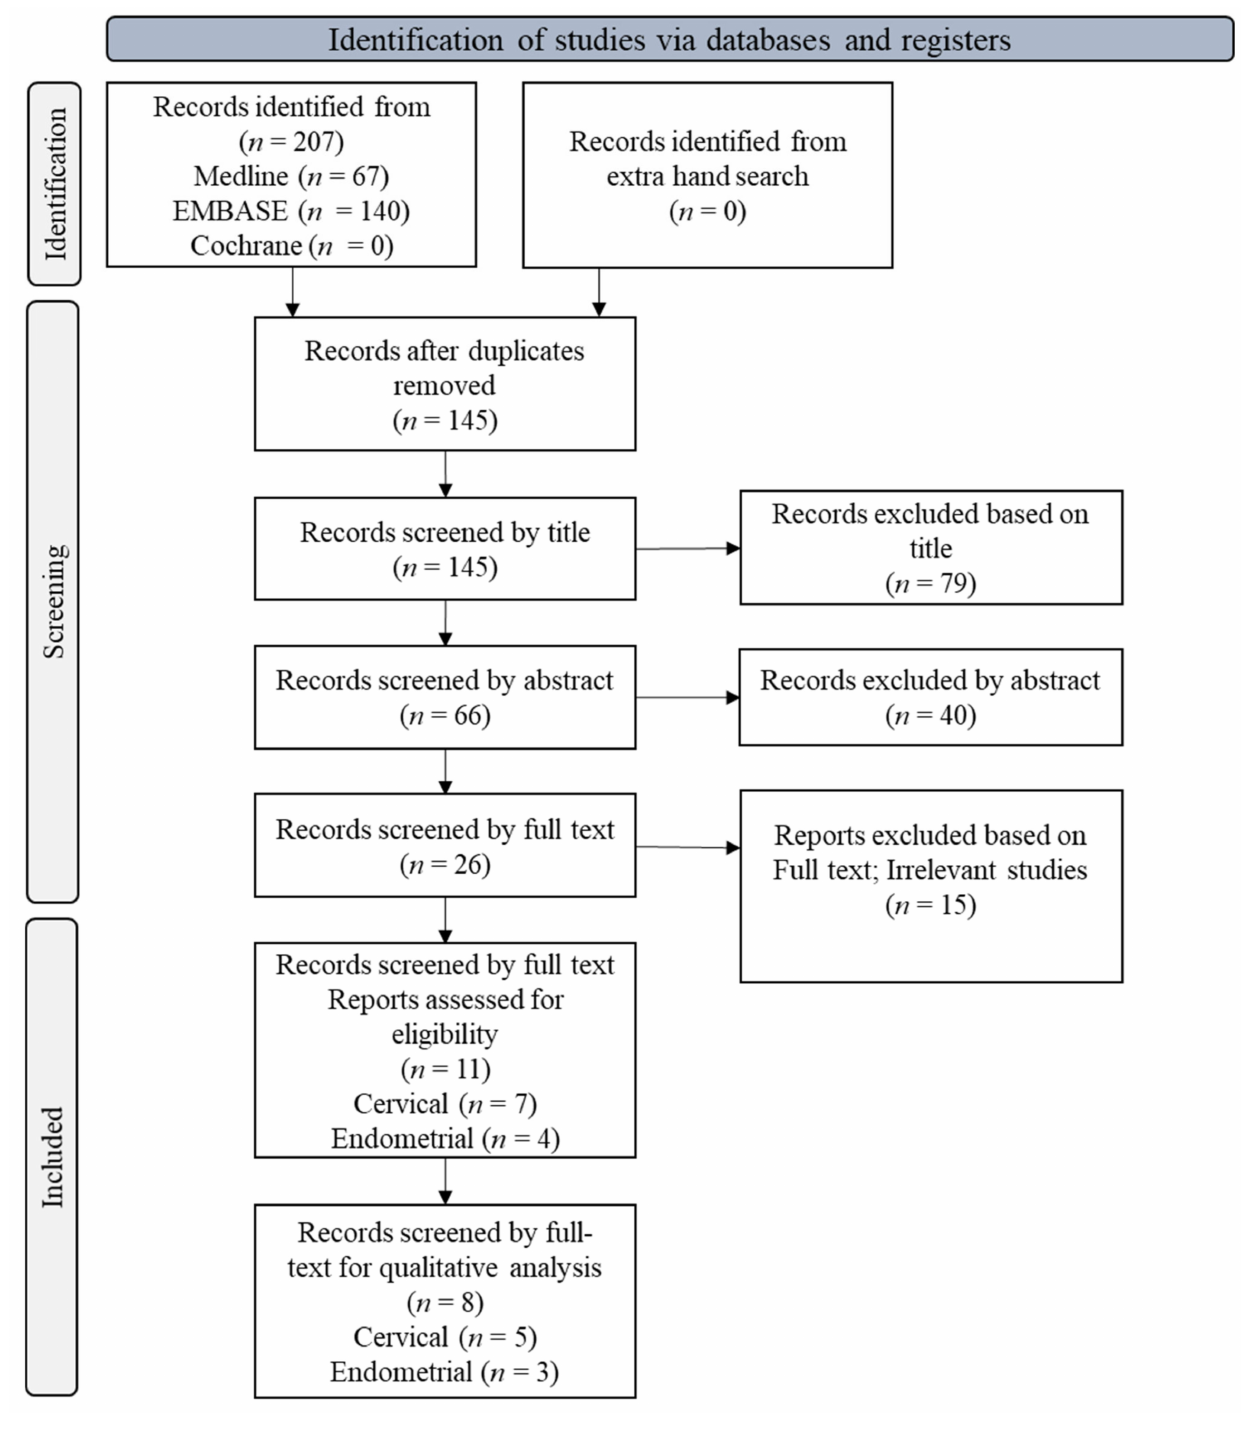
Figure 1. PRISMA flow diagram showing the study selection